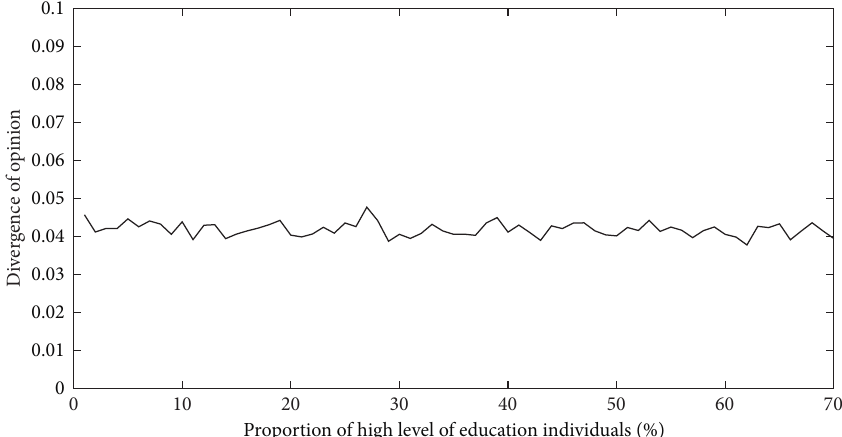
Figure 8: Influence of distribution of high knowledge on the result of evolution.